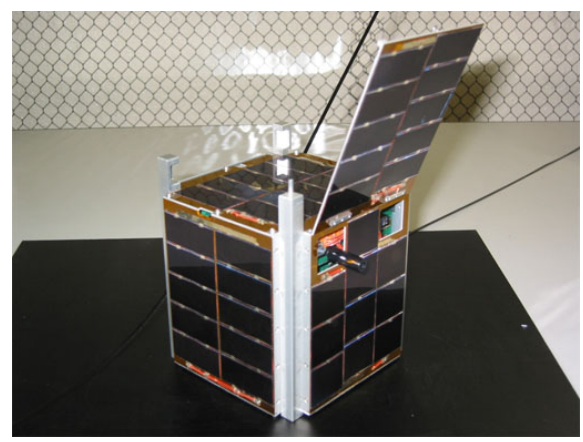
Figure 1. CUTE-I satellite flight model